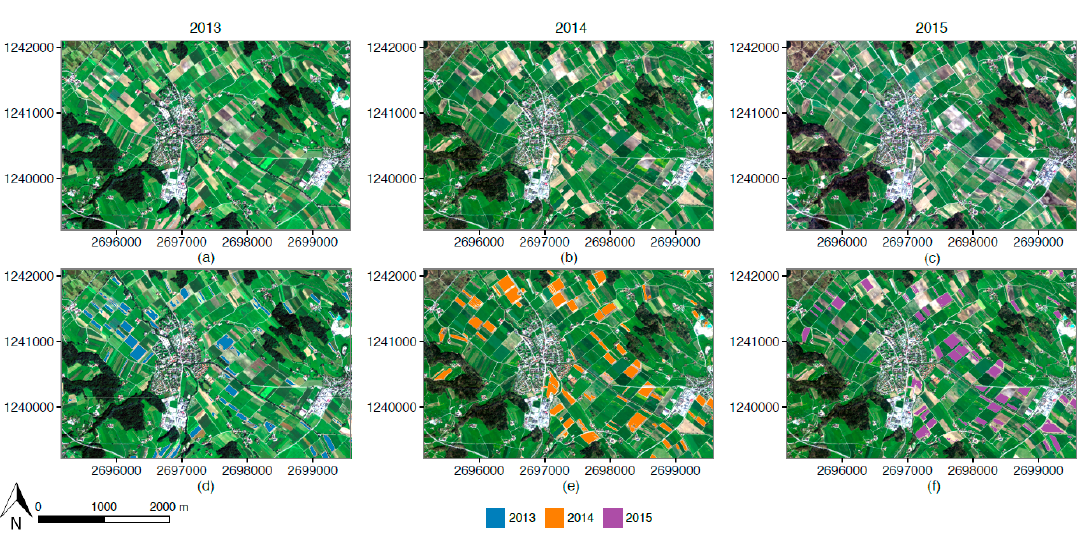
Figure 3. (a – c ) RGB-image of the focus area of the spectroscopy data for all flight dates (3 September 2013, 11 April 2014 and 10 April 2015); and ( d – f ) the corresponding selected bare soils for all three years.